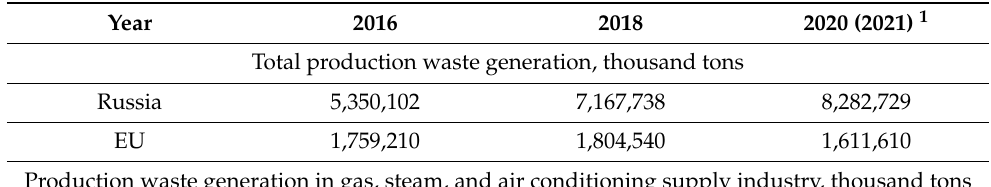
Table 1. Production waste generation in electricity, gas, steam, and air conditioning supply industry in EU and Russia from 2016 to 2020 (made by authors using data from